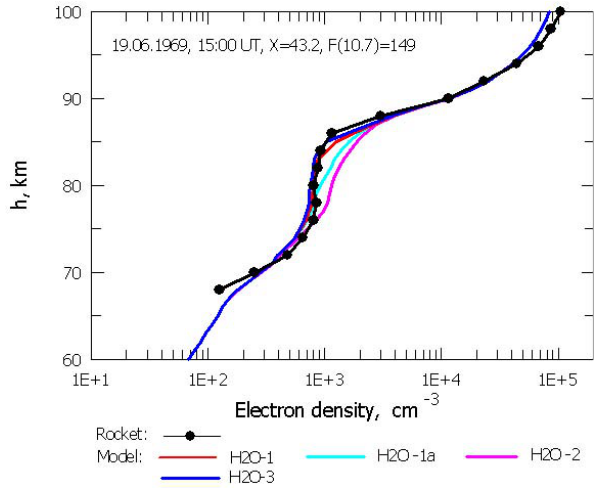
and Cl + positive ions 1 2